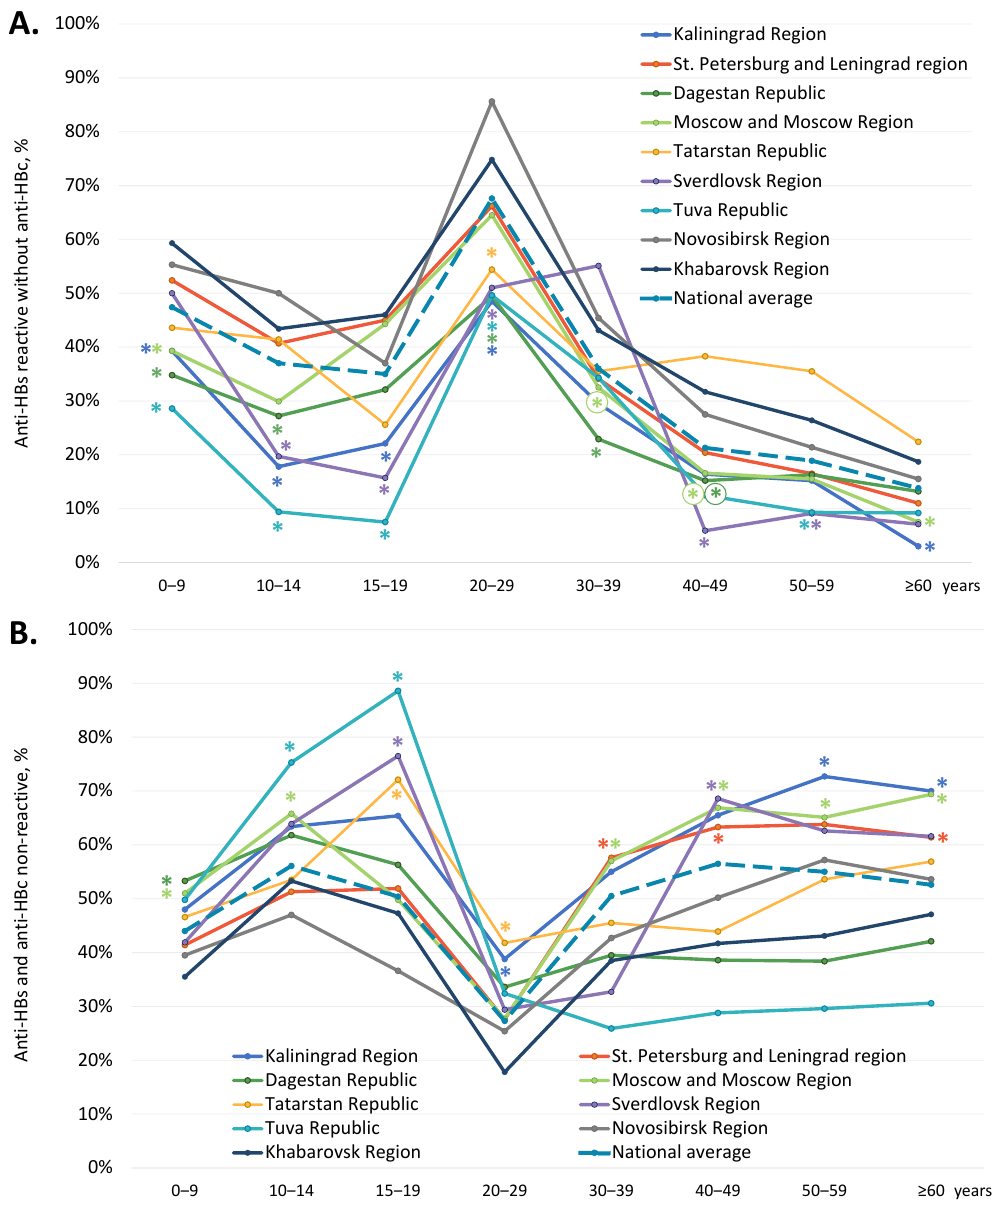
Figure 3. Age-specific proportions of serum samples reactive for anti-HBs but non-reactive for anti- HBc antibodies ( A ), and non-reactive for either anti-HBs or anti-HBc ( B ). Values significantly lower (Panel A ) or higher (Panel B ) than the national average values (two-tailed p < 0.05, Chi-square with Yates’ correction) are marked with an asterisk